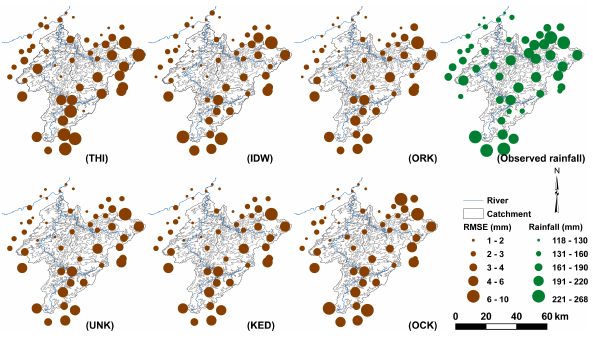
Fig. 12. RMSE and total observed rainfall maps for series of a se- lected period of winter (16 to 30 December 1993). The background is the contour line of the